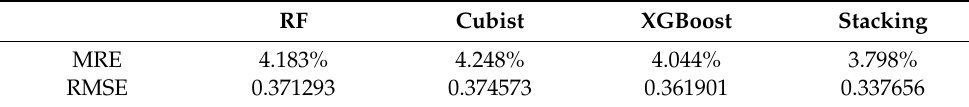
Table 1. Accuracy evaluation of estimated WKS maps.